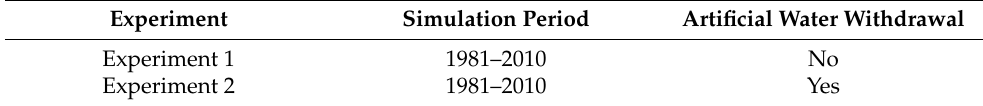
Table 2. Land surface simulation experiments in the Yangtze River